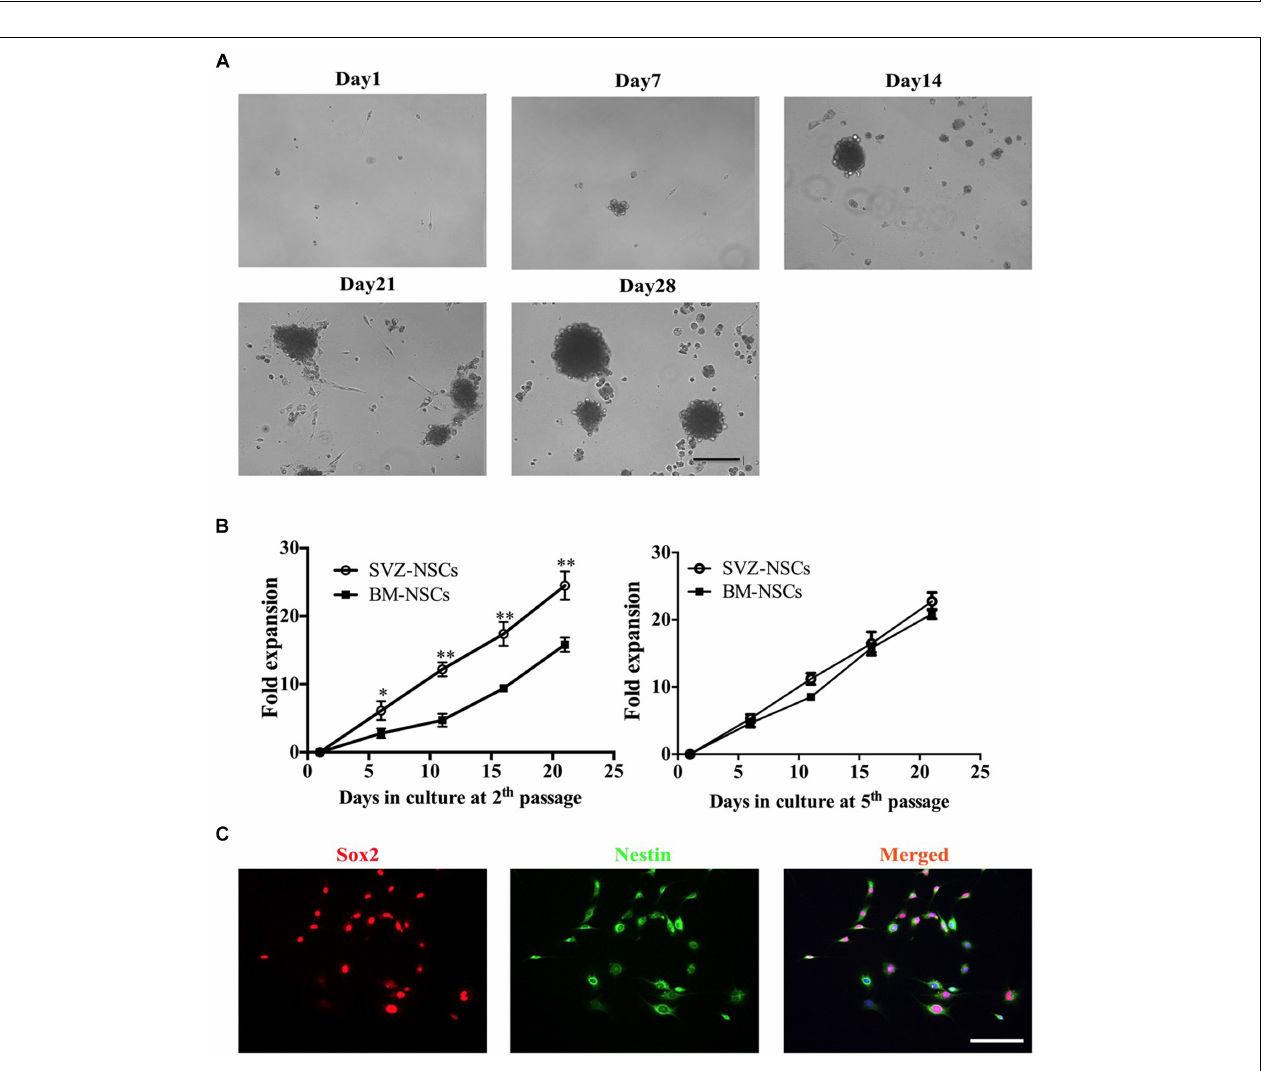
Frontiers in Cellular Neuroscience |